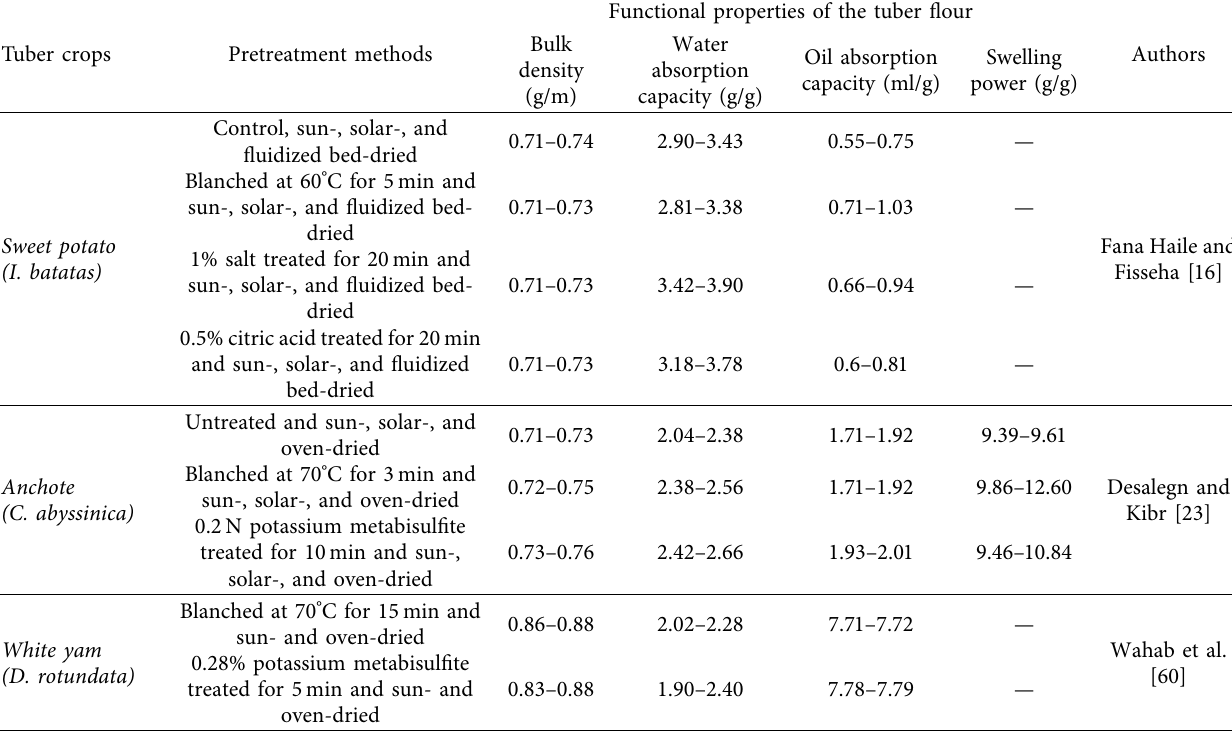
Table 3: Review on the effects of pretreatments on the functional properties of tuber crop. Tuber crops Pretreatment